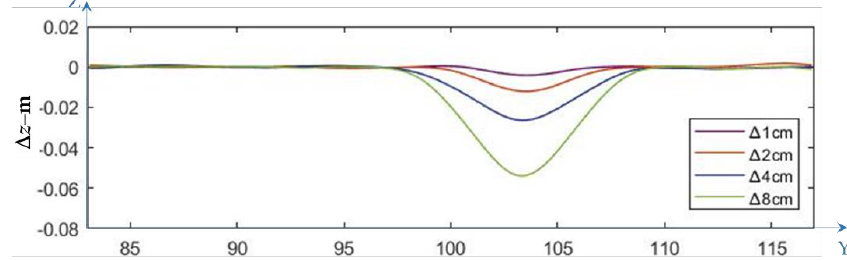
Figure 8. Height difference results (profile through the subsidence center, m).